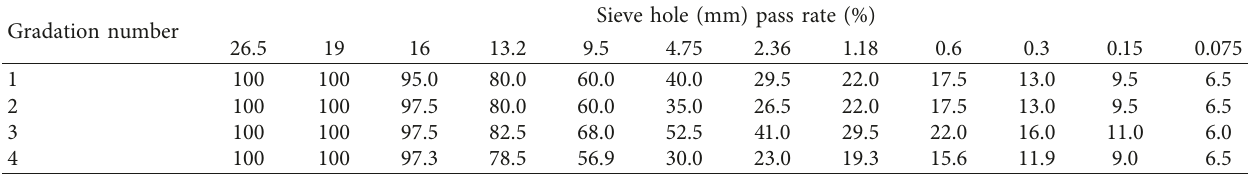
Table 3: Selected AC-16 asphalt mixture design gradations.